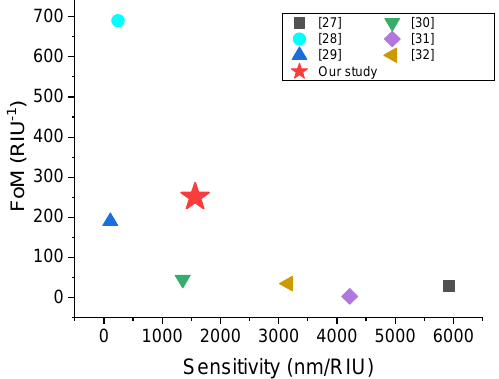
Figure 9. Performance comparison of FoM and sensitivity of the sensor proposed in this study to similar other sensors. The star denotes the current study.